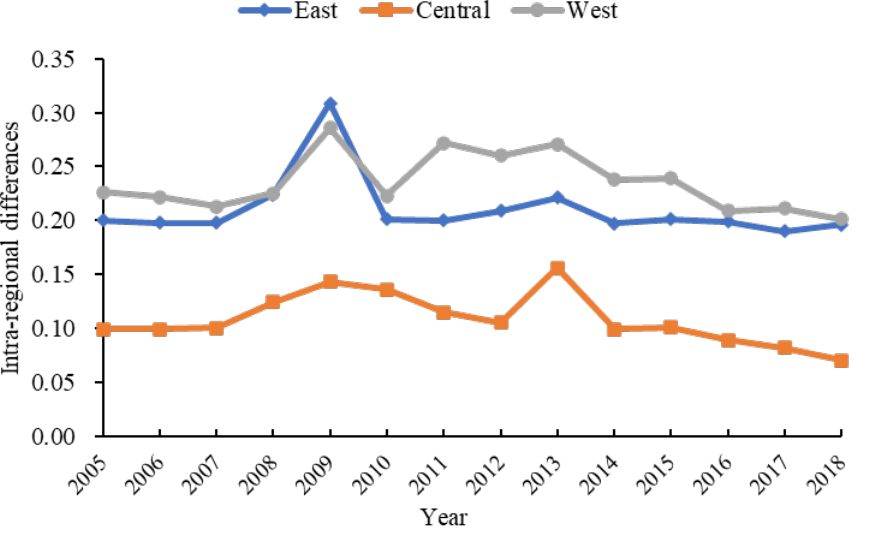
Figure 2. Intra-regional differences in industrial green technology innovation efficiency (GTIE) from 2005 to 2018.